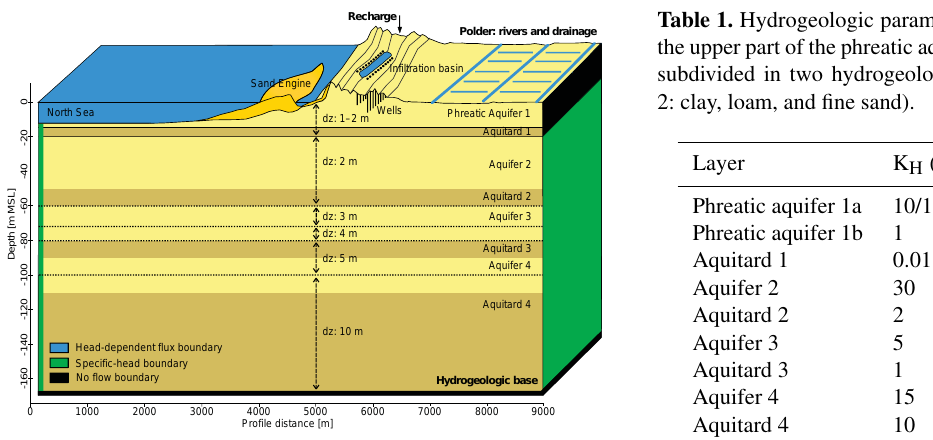
Figure 4. Conceptual representation of a slice of the model with layer thicknesses and boundary conditions.